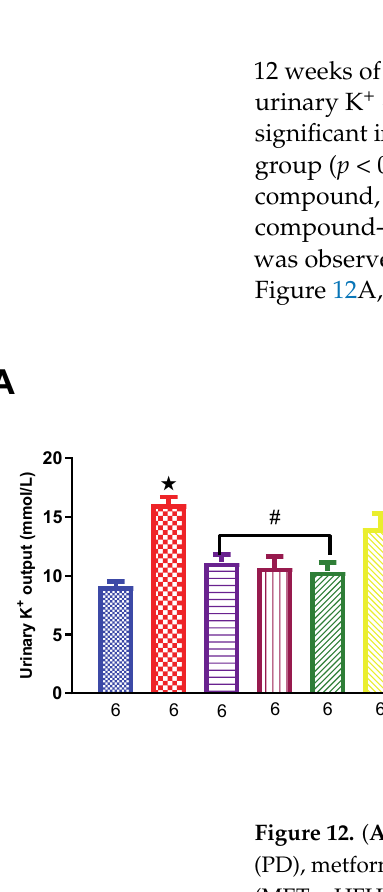
and high-fat/high-carbohydrate diet (Re + HFHC) groups after 12 weeks of treatment. Values are